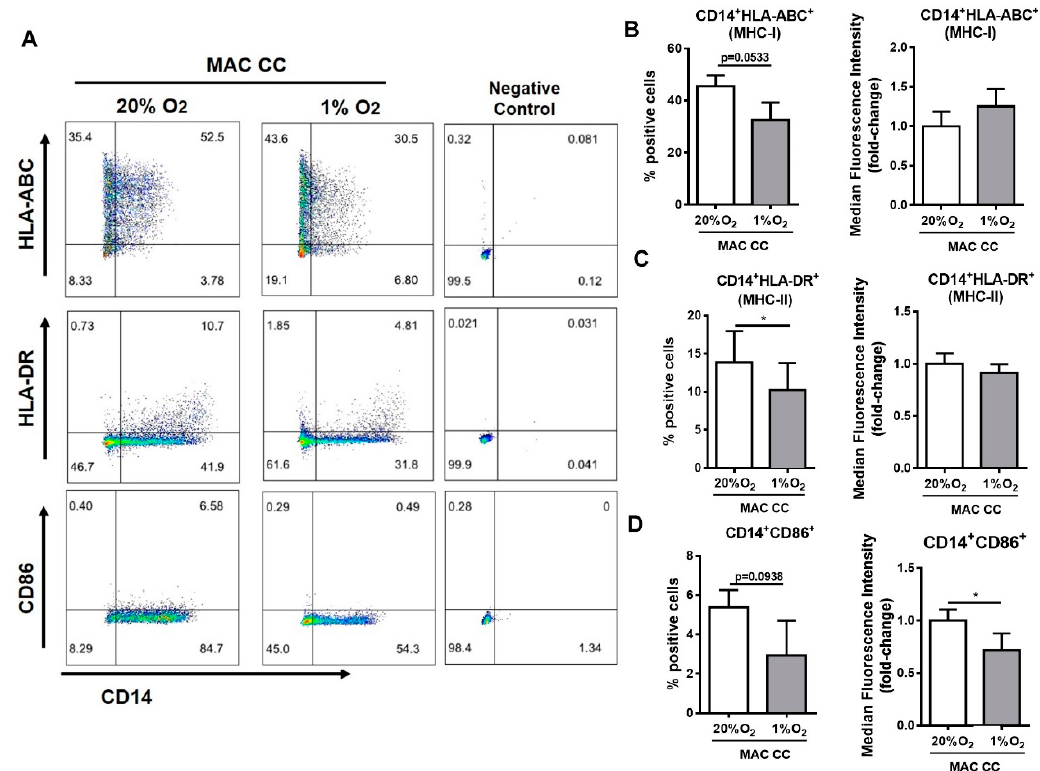
Figure 2. Hypoxia impacts macrophage antigen-presentation associated molecules. Macrophages were indirectly co-cultured with colon cancer cells RKO (MAC CC), at 20% or 1% O 2 for 72 h. Expression of the monocyte/macrophage lineage marker CD14, HLA-ABC (MHC-I), HLA-DR (MHC-II), and CD86 was determined by flow cytometry. ( A ) Pseudo-color plots display the gating strategy for flow cytometry created with FlowJo. ( B – D ) Graphs represent the percentage and median fluorescence intensity, which is presented as fold-change relatively to 20% O 2 condition of ( B ) CD14+HLA-ABC+, ( C ) CD14+HLA-DR+, or ( D ) CD14+CD86+ cells. Graphs represent the mean values